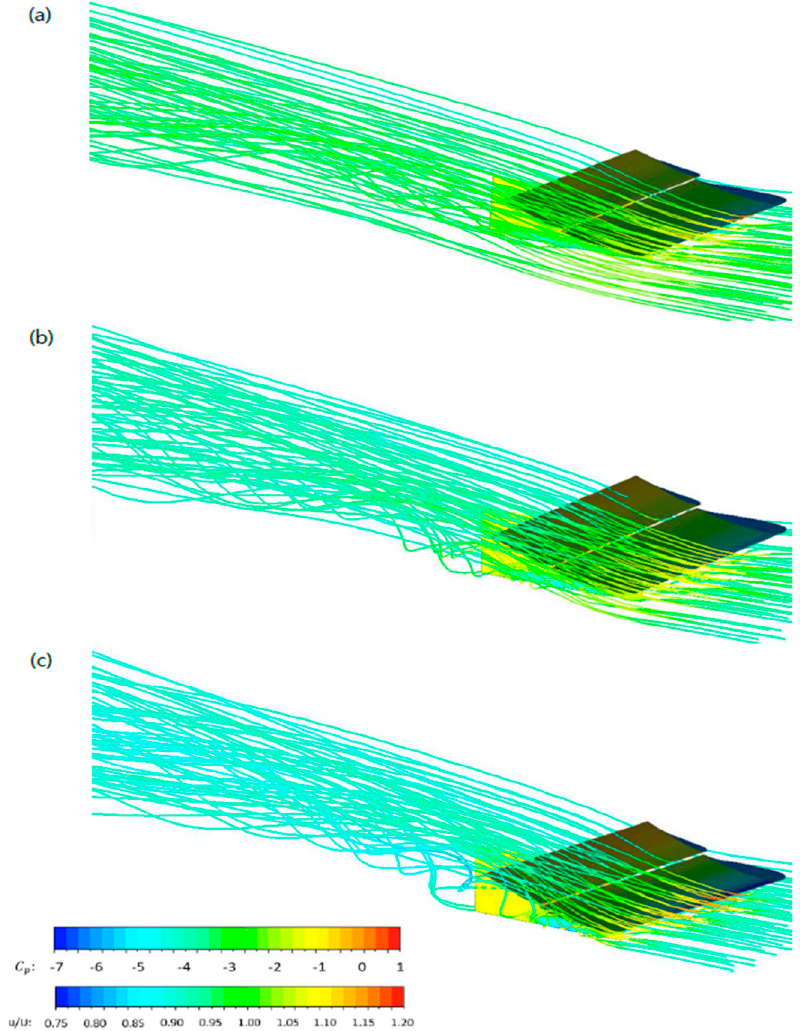
Figure 13. Velocity streamline around the wing and surface pressure coefficient at different ride heights ( a ) h/c = 0.395, ( b ) h/c = 0.211, ( c ) h/c = 0.105.